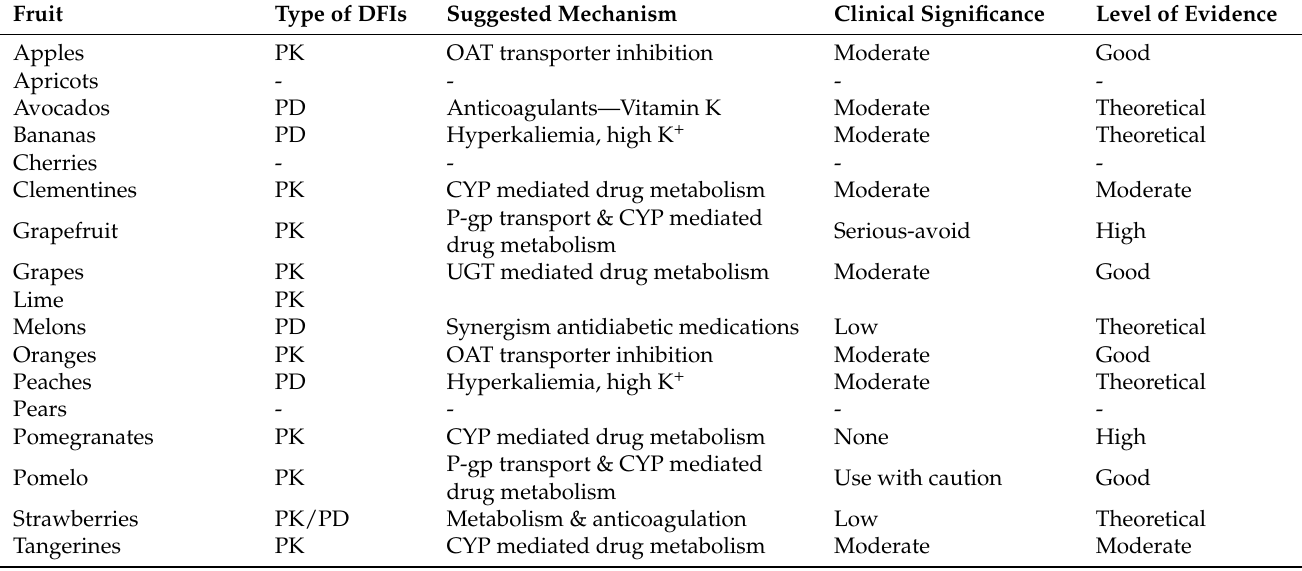
Table 2. DFIs, pharmacological mechanism, significance, and level of evidence for fruits that are contained in the base of Med-D pyramid (PK: pharmacokinetic, PD: Pharmacodynamic, DFI: drug- food interaction).